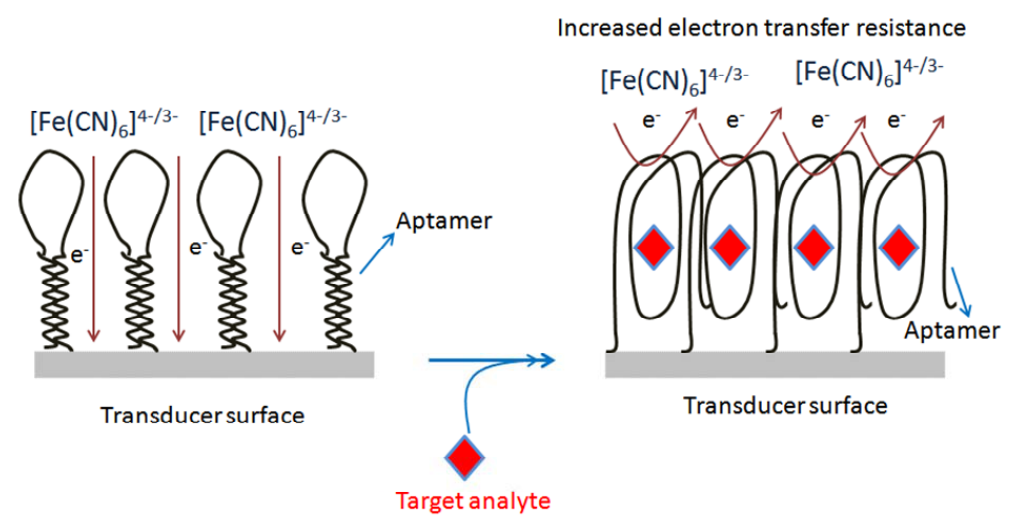
Figure 4. Design of PEG-aptamer two piece macromolecules integrated sensing platforms